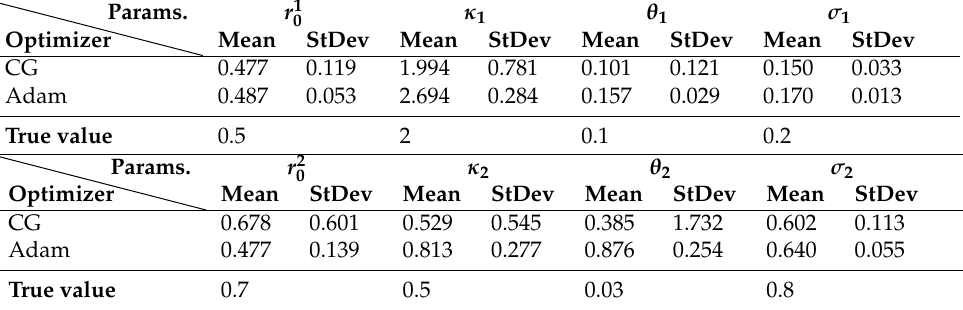
Table 2. Calibration results with mean and standard deviations (StDev) of the learned parameters (params.) of 1000 simulated log-bond prices and log tenor- δ bond prices, as well as the true Vasiˇcek parameters. We note that the CG optimizer yields for every parameter a higher standard deviation than the Adam algorithm. This can in particular be observed for the parameter θ 2